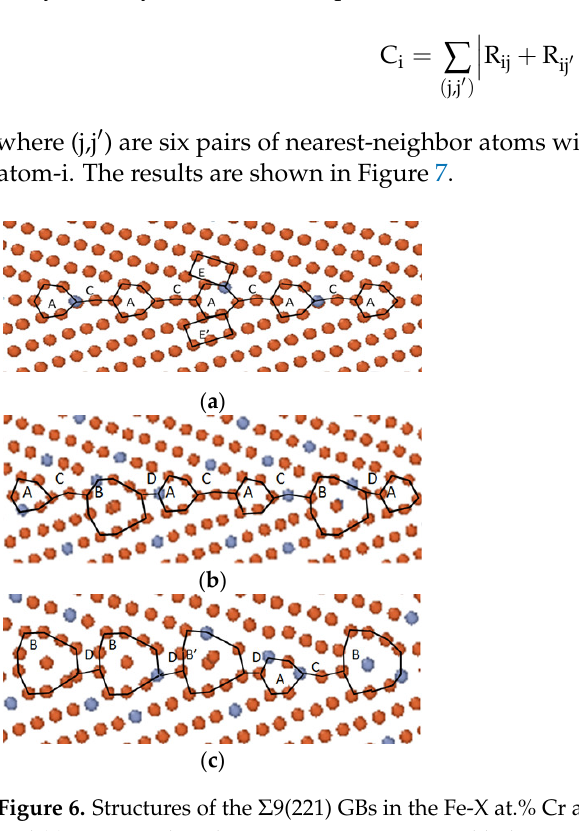
Figure 7. Atomic symmetric central parameters of the Σ9(221) GBs and Σ17(223) GBs in pure Fe and Fe-X at.% Cr alloys (X = 1, 3, 5, 7, and 9).